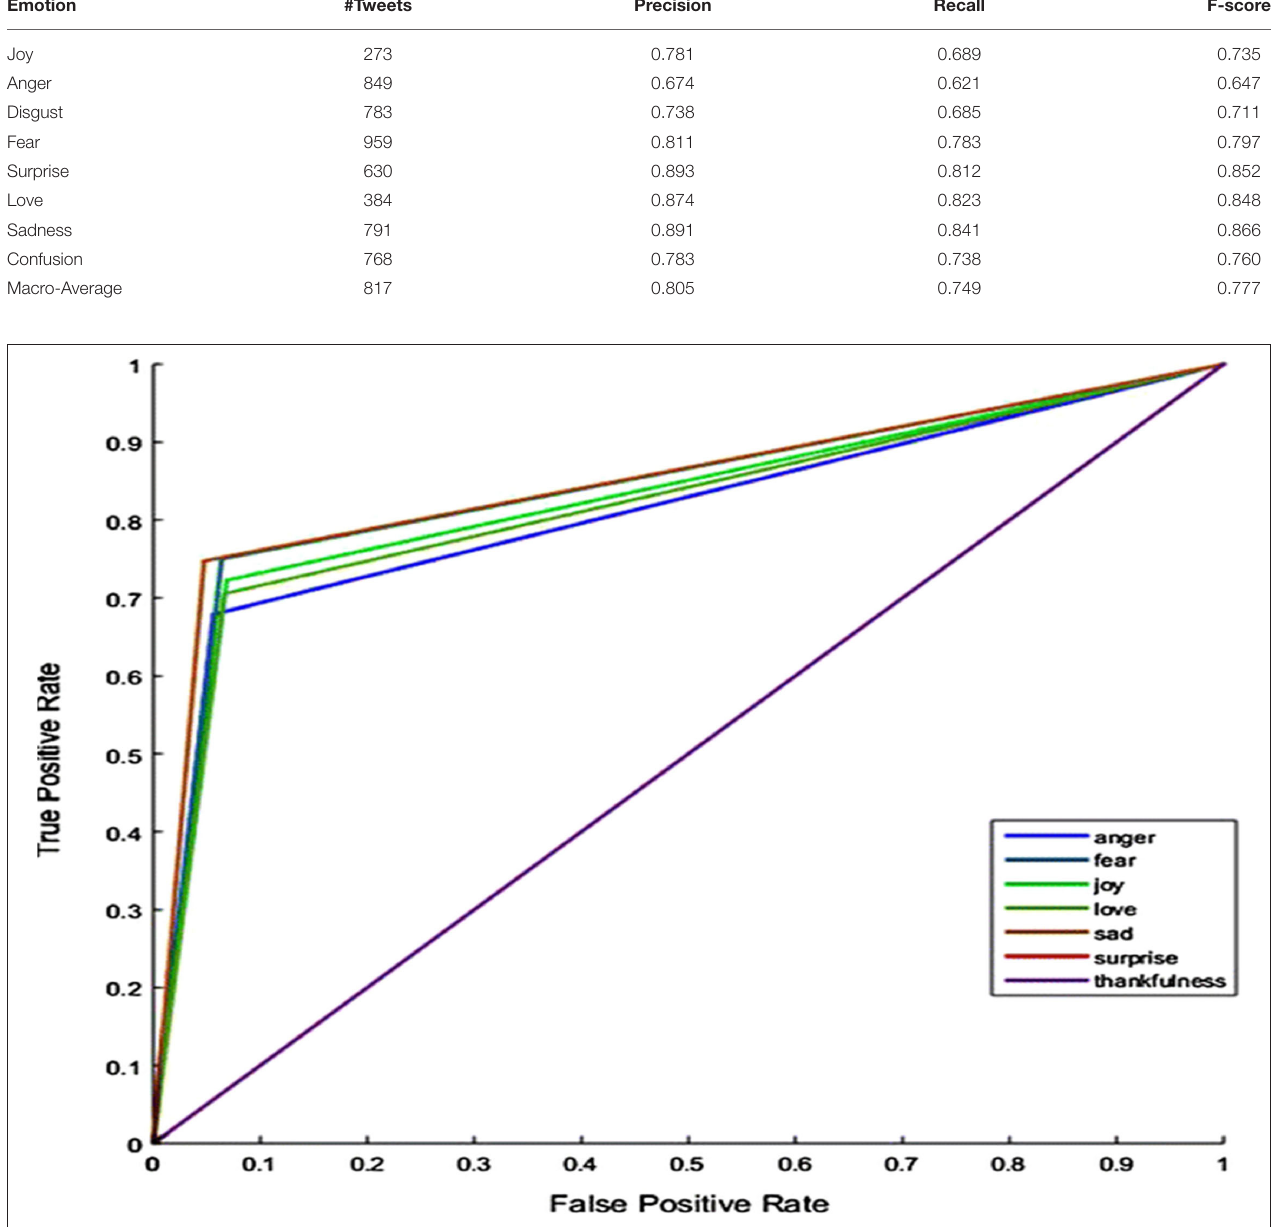
FIGURE 5 | ROC curve—emotions classifier for the COVID-19